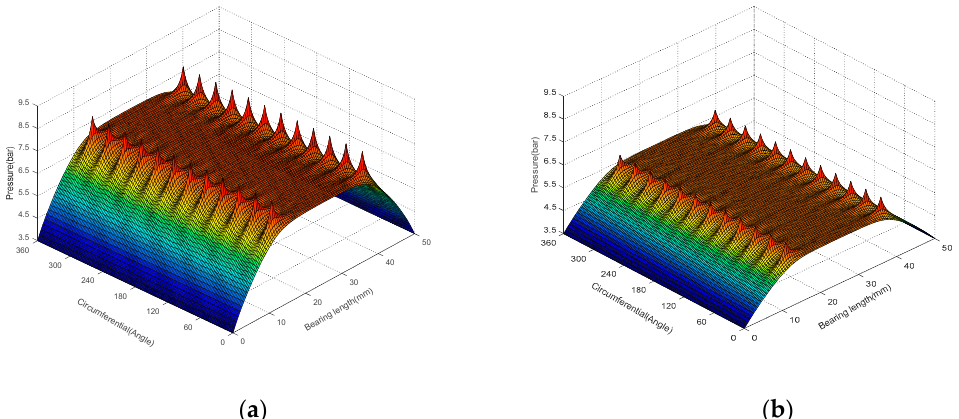
Figure 4. Pressure distribution of journal bearing ( ω = 0, ε = 0, p s = 0.95 MPa, h 0 = 20 μ m, d = 0.3 mm) ( a ) air ( b ) R134a.